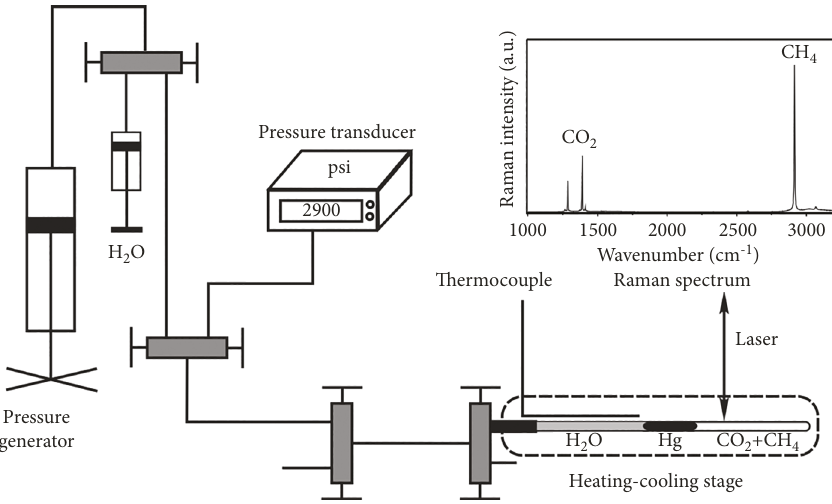
Figure 1: Schematic diagram of the experimental system (modified after Lu et al.